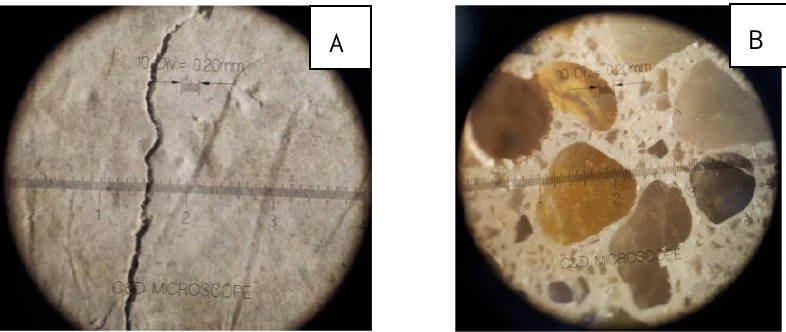
Figure 1. Crack Measurement Microscope images for ( A ) G66 (external surface); and ( B ) E66 (polished surface).